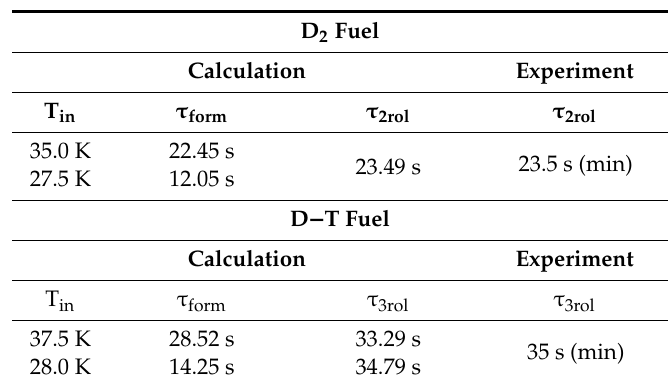
Table 3. FST layering for both D 2 and D −